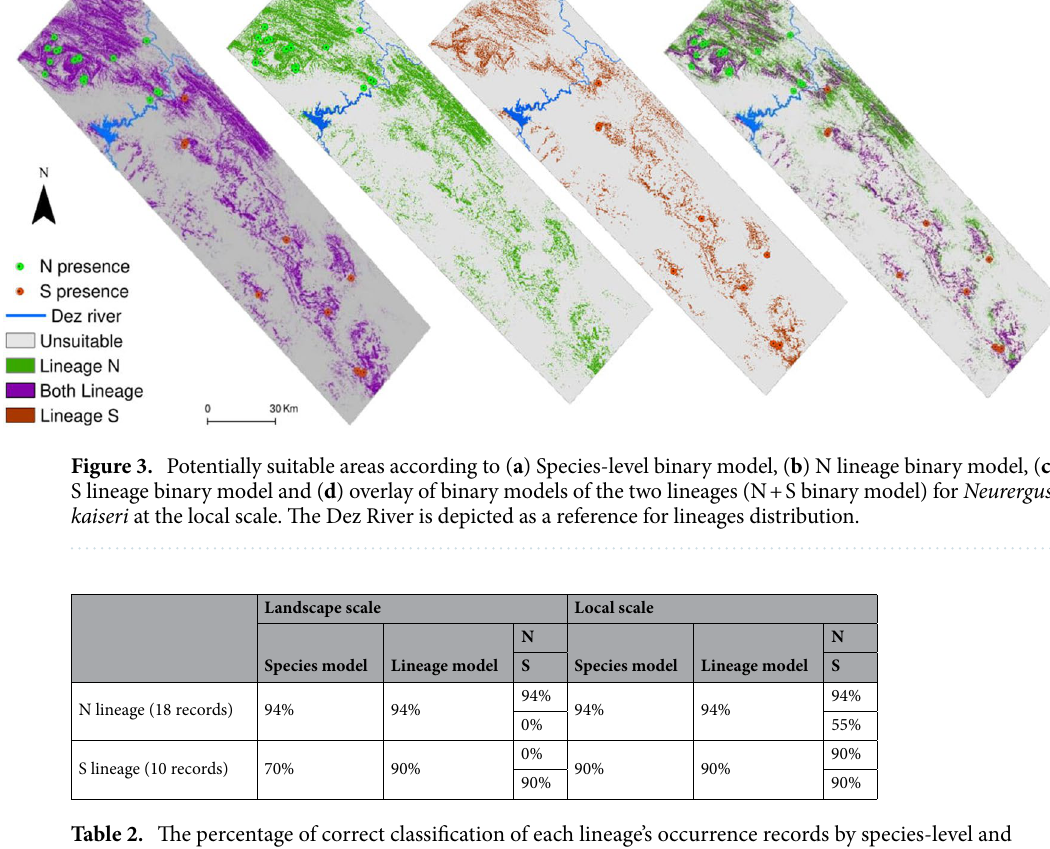
Table 2. The percentage of correct classification of each lineage’s occurrence records by species-level and lineage-level models for each of the two studied landscape and local scales, and the percentage of correct classification of each lineage’s records by another model (cross-prediction) based on minimum training presence of known occurrences.